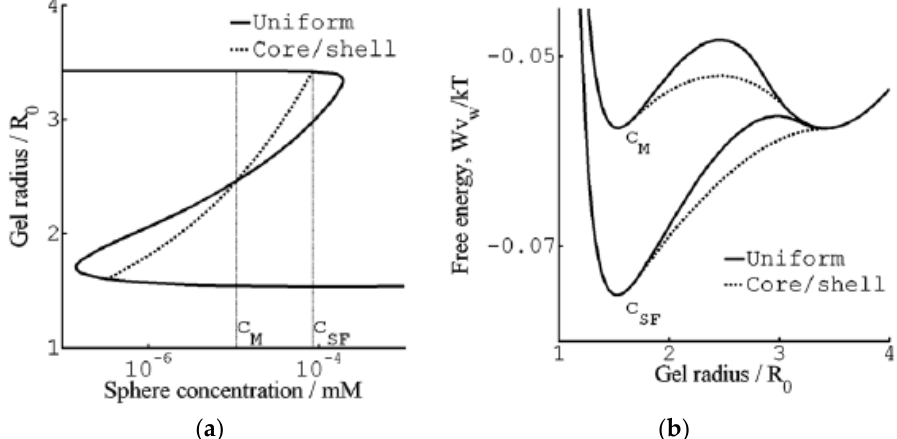
Figure 7. ( a ) Theoretically calculated swelling isotherm for spherical gel in a large solution of macroion with charge + 12 and 40 mM salt other parameters as in Figure 6a; ( b ) free energy of the same system as function of gel radius relative the radius in a relaxed reference state (R 0 ), for uniform (solid curves) and core–shell states (dotted). [72] Reproduced by permission of the Royal Society of Chemistry.